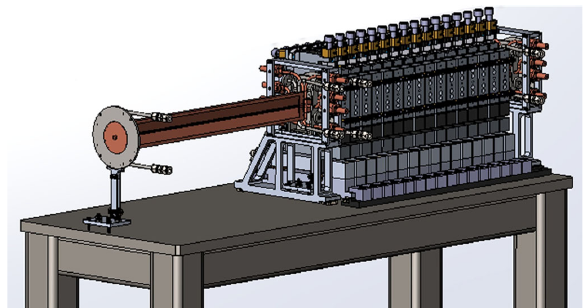
FIG. 1. Two 0.5-m long modules of the CWA connected in series, showing the module on the left with the quadrupole wiggler